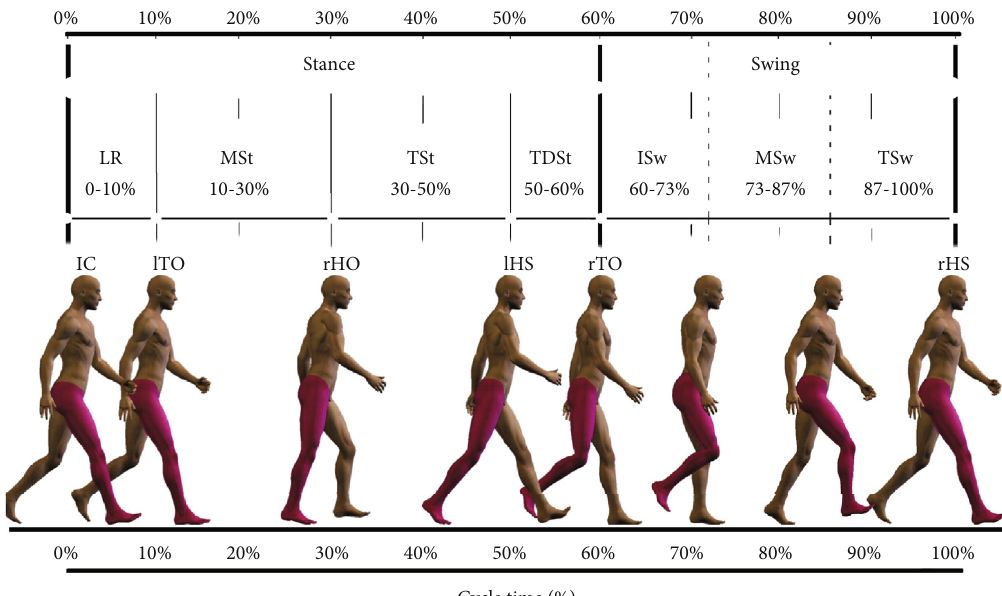
Figure 1: Gait terminology adopted in the analysis. Division of the gait cycle into phases: pelvic tilt (anterior/posterior), hip fl exion/extension, knee fl exion/extension, and ankle plantar fl exion/dorsi fl exion; sagittal